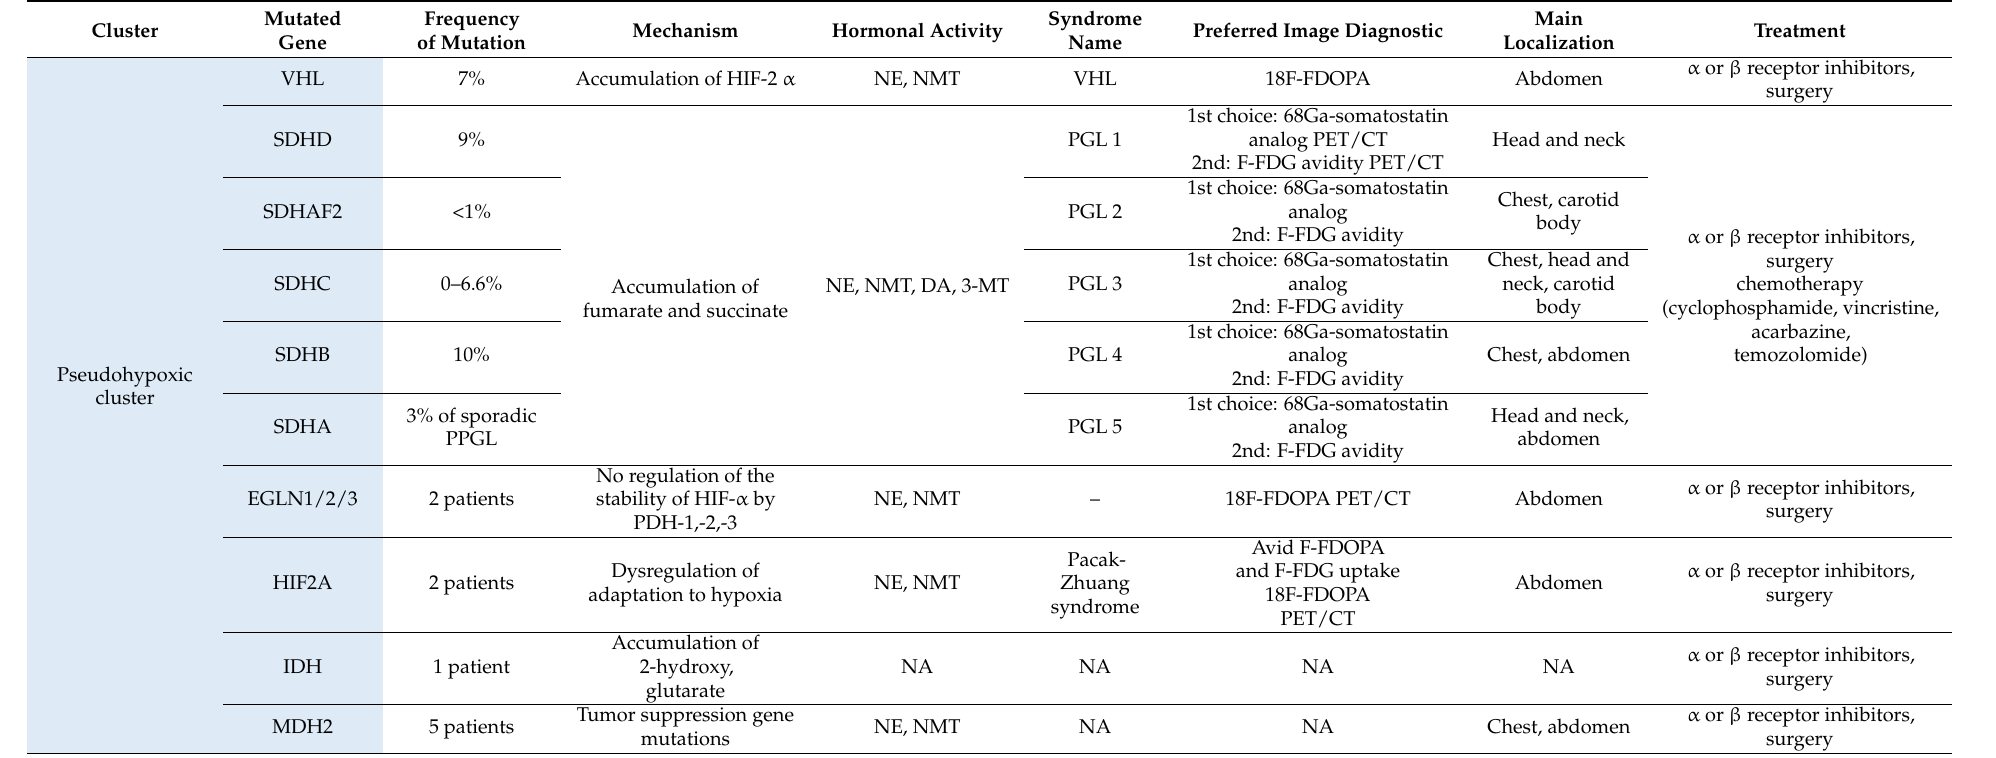
Table 2. Clinical data according to a mutation. Summarized data available in the literature. Non-specific (NS) [15–31].